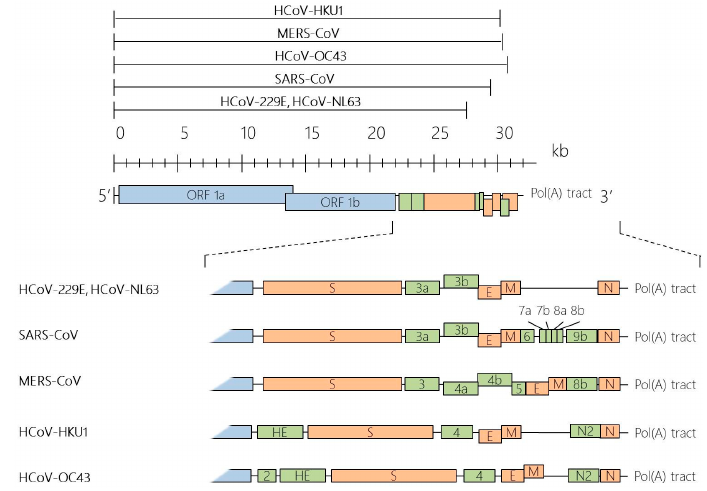
Figure 1. Genome organisation of human coronaviruses (HCoVs). HCoV genomes range from about 26 to 32 kilobases (kb) in size, as indicated by the black lines above the scale. Coronavirus (CoV) genome is typically arranged in the order of 5 ′ -ORF1a-ORF1b-S-E-M-N-3 ′ . The overlapping open reading frames (ORF) ORF1a and ORF1b comprise two-thirds of the coronavirus genome, which encodes for all the viral components required for viral RNA synthesis. The other one-third of the genome at the 3 ′ end encodes for a set of structural ( orange ) and non-structural proteins ( green ).